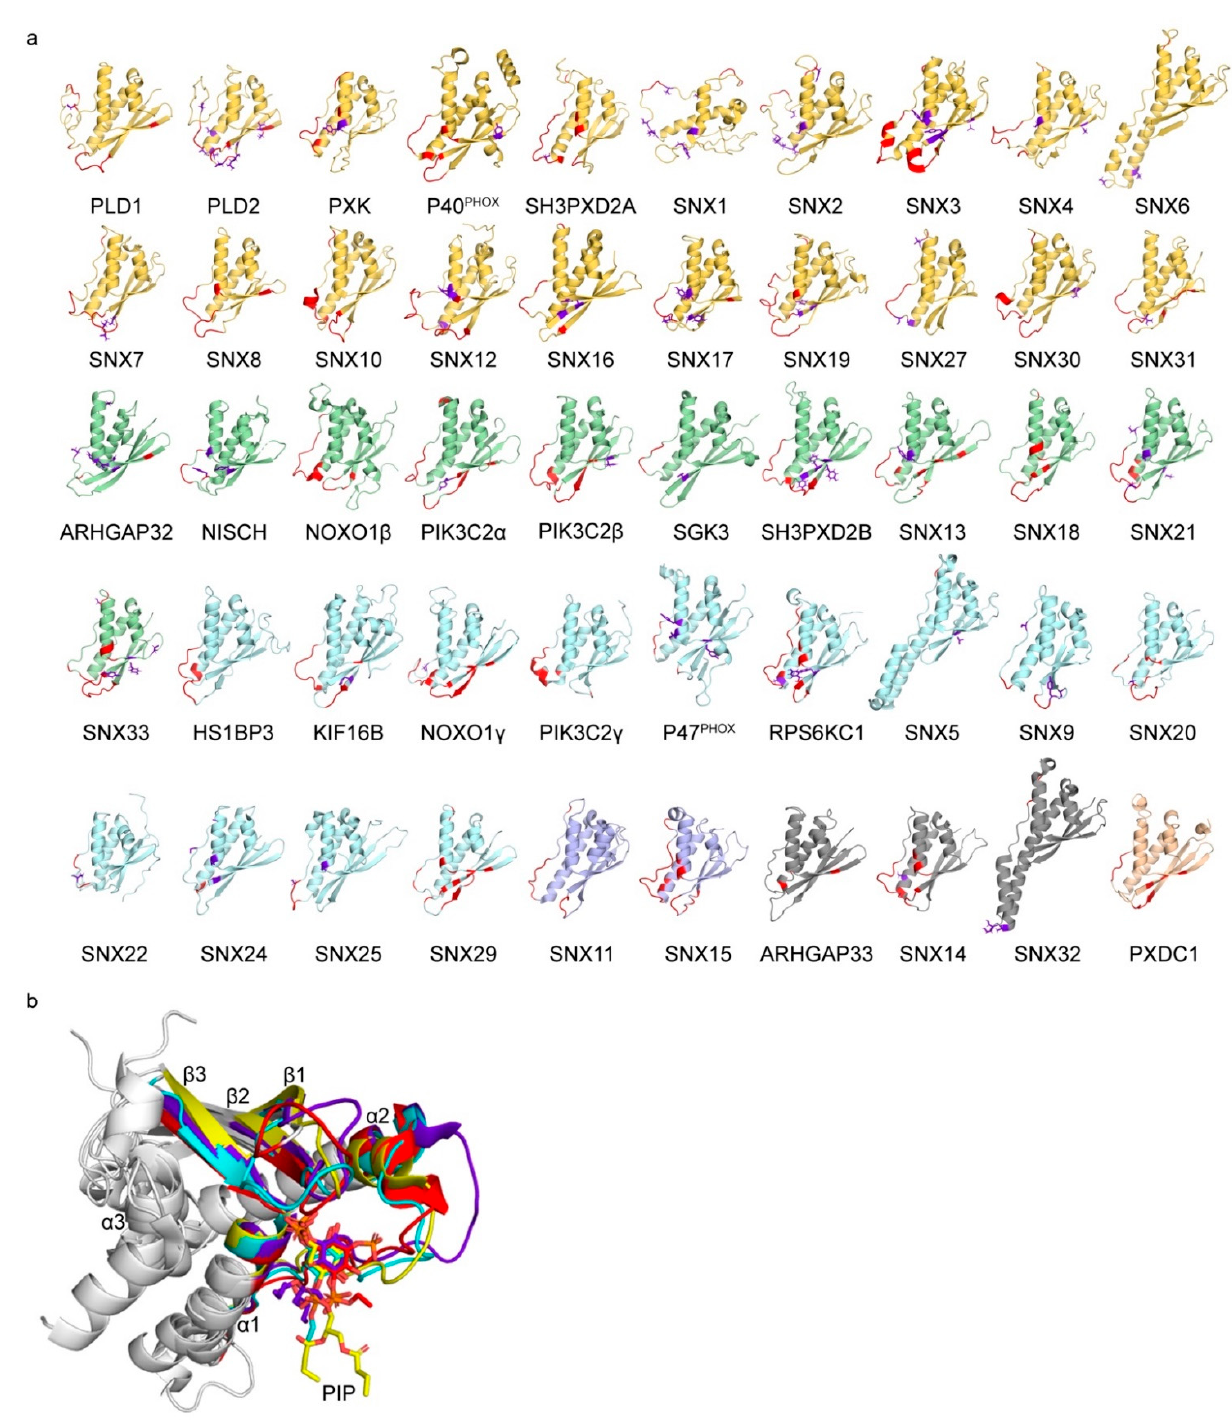
Figure 2. Structures of all human PX domains. ( a ) Ribbon models are shown with residues in membrane-interacting sites based on MODA scores greater than 30 and are shown in red. Phosphorylated residues in Sites 1, 2, and 3 are shown in purple with their side chains indicated. Backbone ribbon colors correspond to LSI values of 1–4 (purple); 5–7 (light blue), 8–9 (green), 10 (yellow), does not bind PIPs (grey) and no data available (beige). ( b ) The structural elements of superimposed PIP-bound PX domain structures of Grd19 (1ocu), p40 phox (1h6h), SNX9 (2rak), and SNX11 (6koj) are labelled with Sites 1, 2, and 3, and the carbon atoms of the PIPs belonging to each structure are colored red, yellow, cyan and purple, respectively. The literature was surveyed for lipid binding data for each PX domain, with the relevant PIP specificities for human and yeast proteins shown in Table 1. Studies of